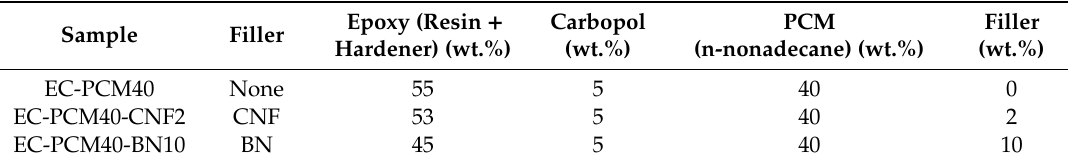
Table 1. Epoxy-PCM-Filler sample formulation